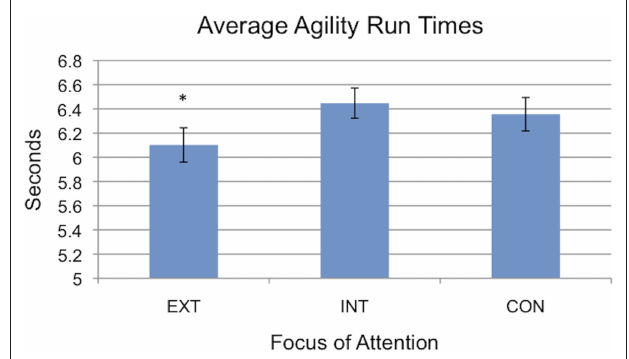
Figure 1 | Agility “L” test. Participant begins at start line beside cone A. Run toward cone B, pivot around cone B and run toward cone C. Run around cone C and run back toward cone B. Pivot around cone B and run across finish line.